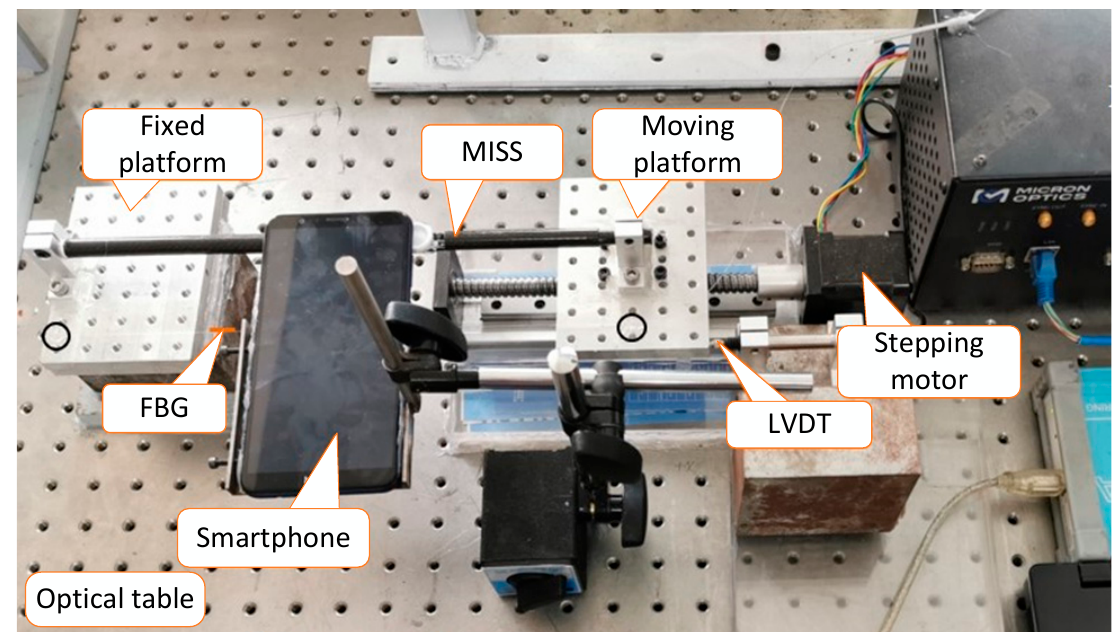
Figure 4. Schematic diagram of the field test arrangement.